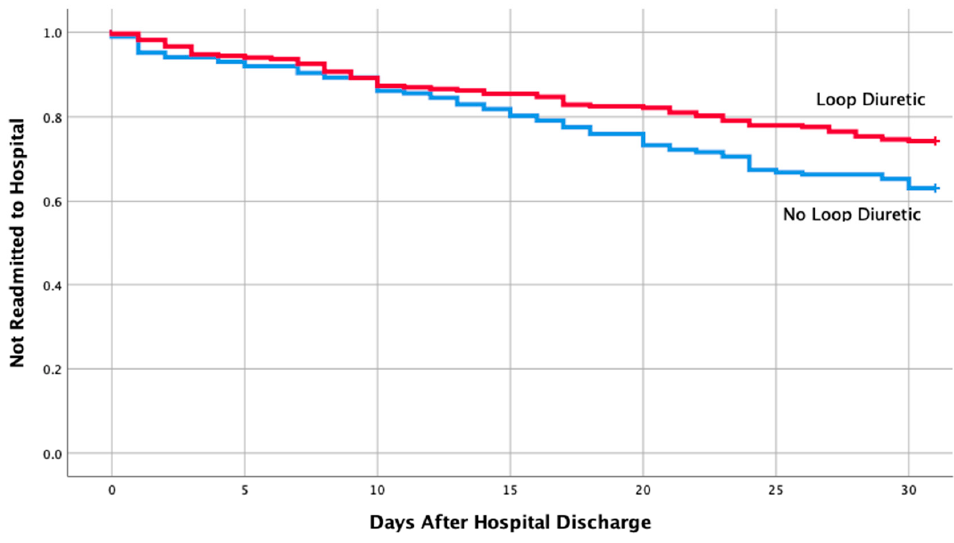
Figure 2. Readmission free survival for patients treated with loop diuretics.